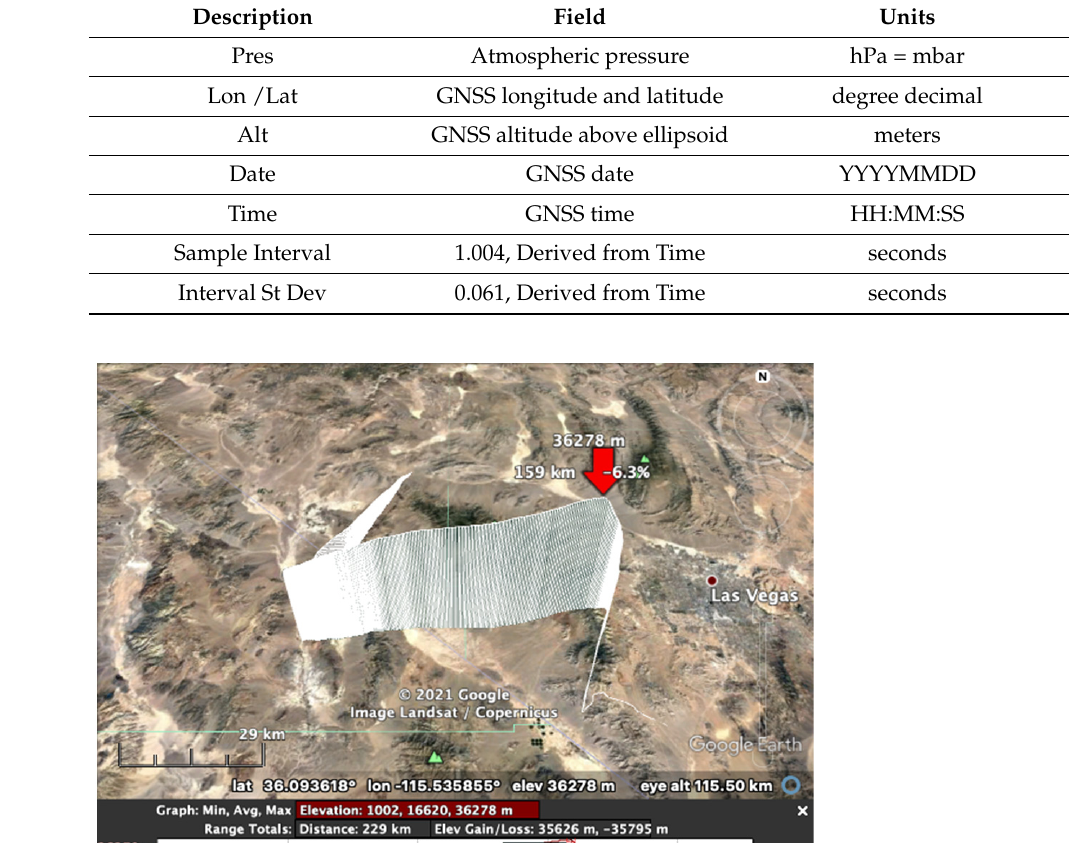
Table 2. Bounder Location Sensor.